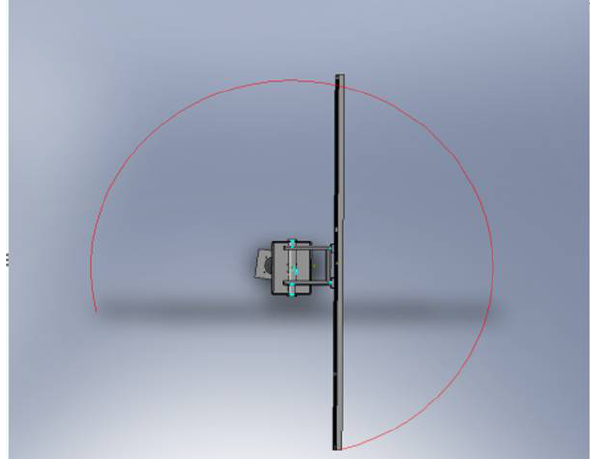
Figure 14. Azimuth-axis trajectory